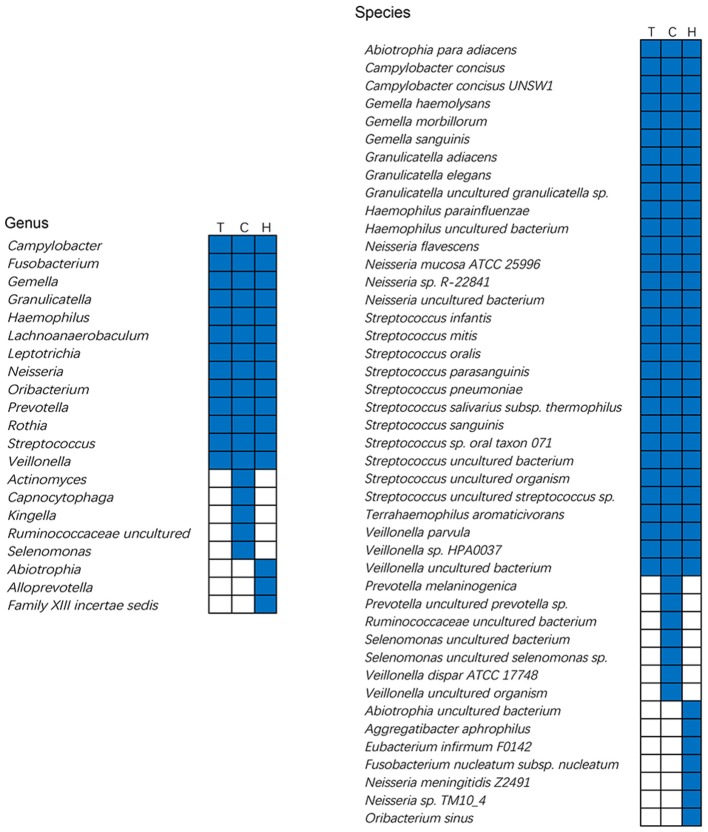
Core microbiome of caries and caries free group at the genus and species level. Each column represents a group. For each column, the black cells indicate that the species or genus listed on the left has fallen into the “core microbiome” of this group and white cells indicate that the species or genus listed on the left could not be observed in all the samples of this group. T, total subjects; C, Caries children; H, Caries free children.